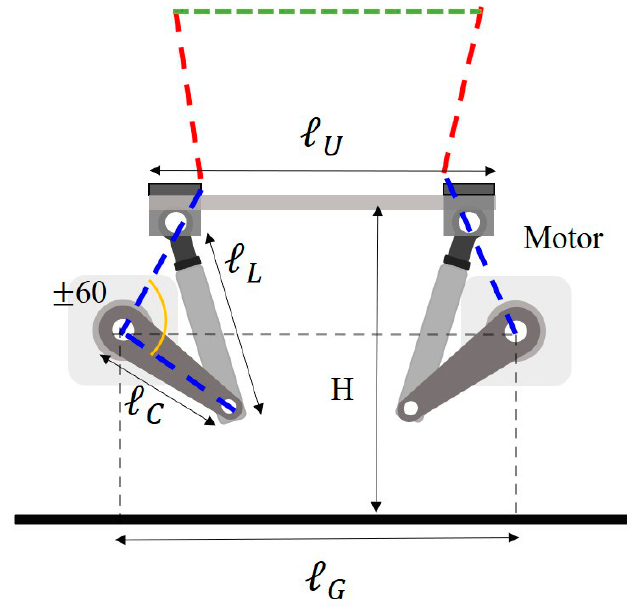
Figure 6. The dimension of the platform.